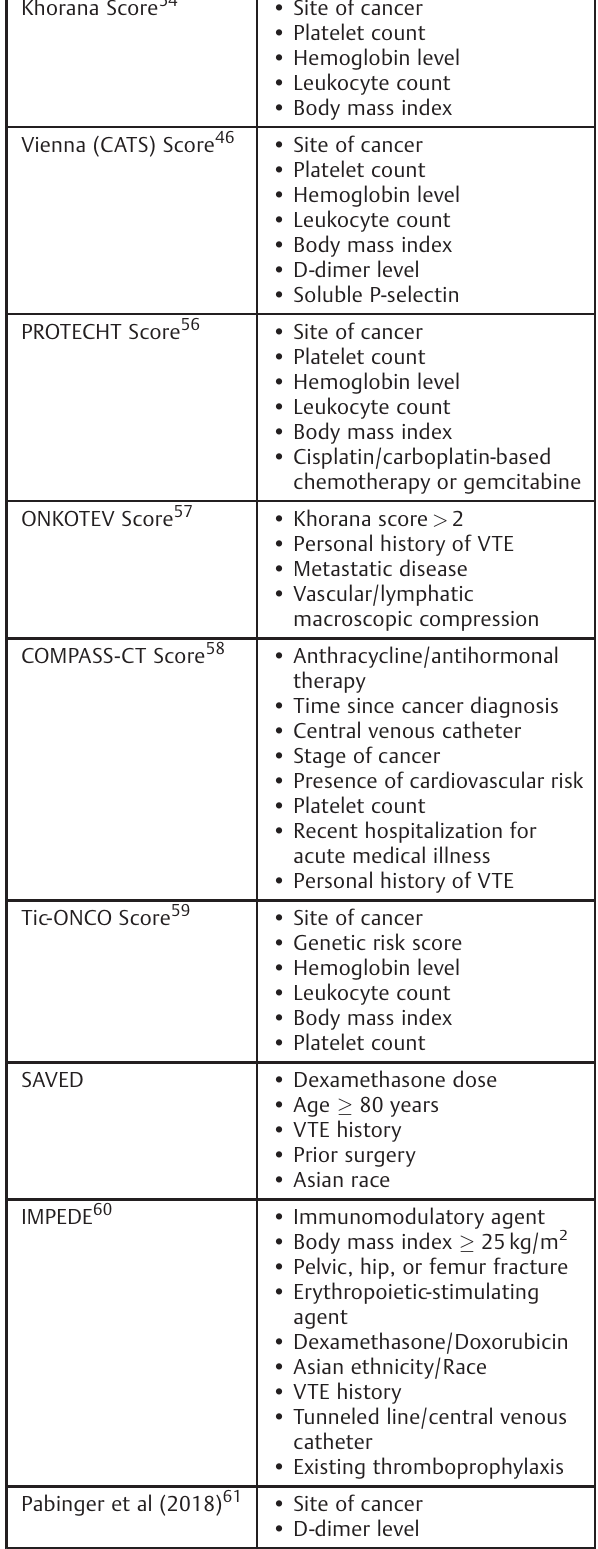
Table 2 Risk assessment models for lung cancer-associated VTE Risk assessment